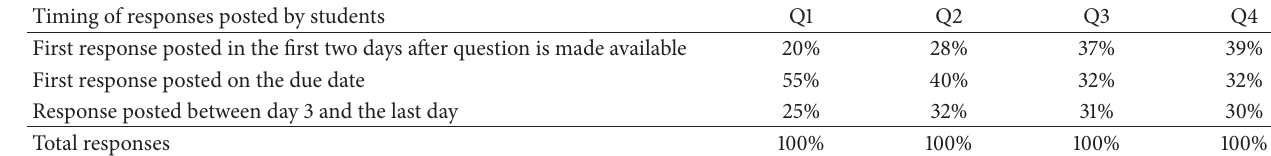
Table 3: Timing of responses posted by